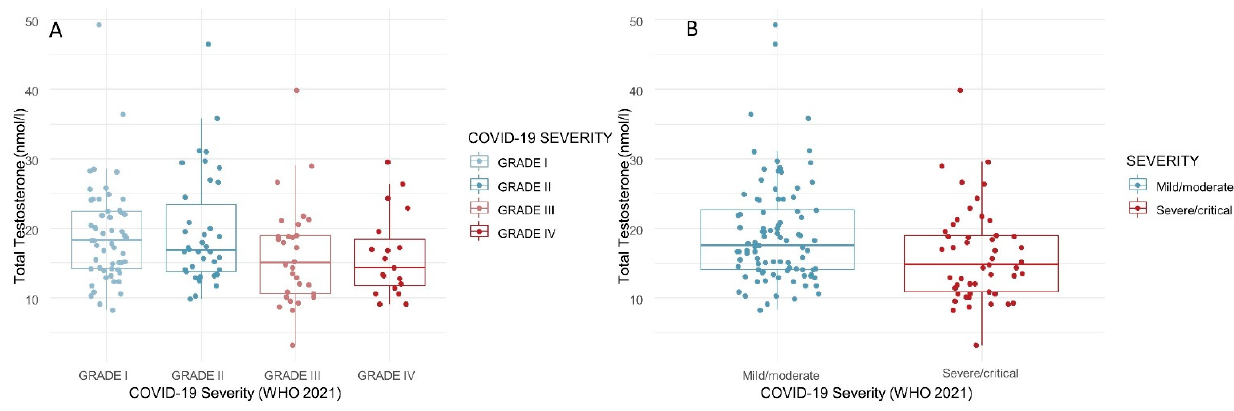
Figure 5. Total testosterone (nmol/L) in COVID-19 survivors, according to disease severity (4 grades, ( A ); 2 grades, ( B )). (4 grades, ( A ); 2 grades, ( B